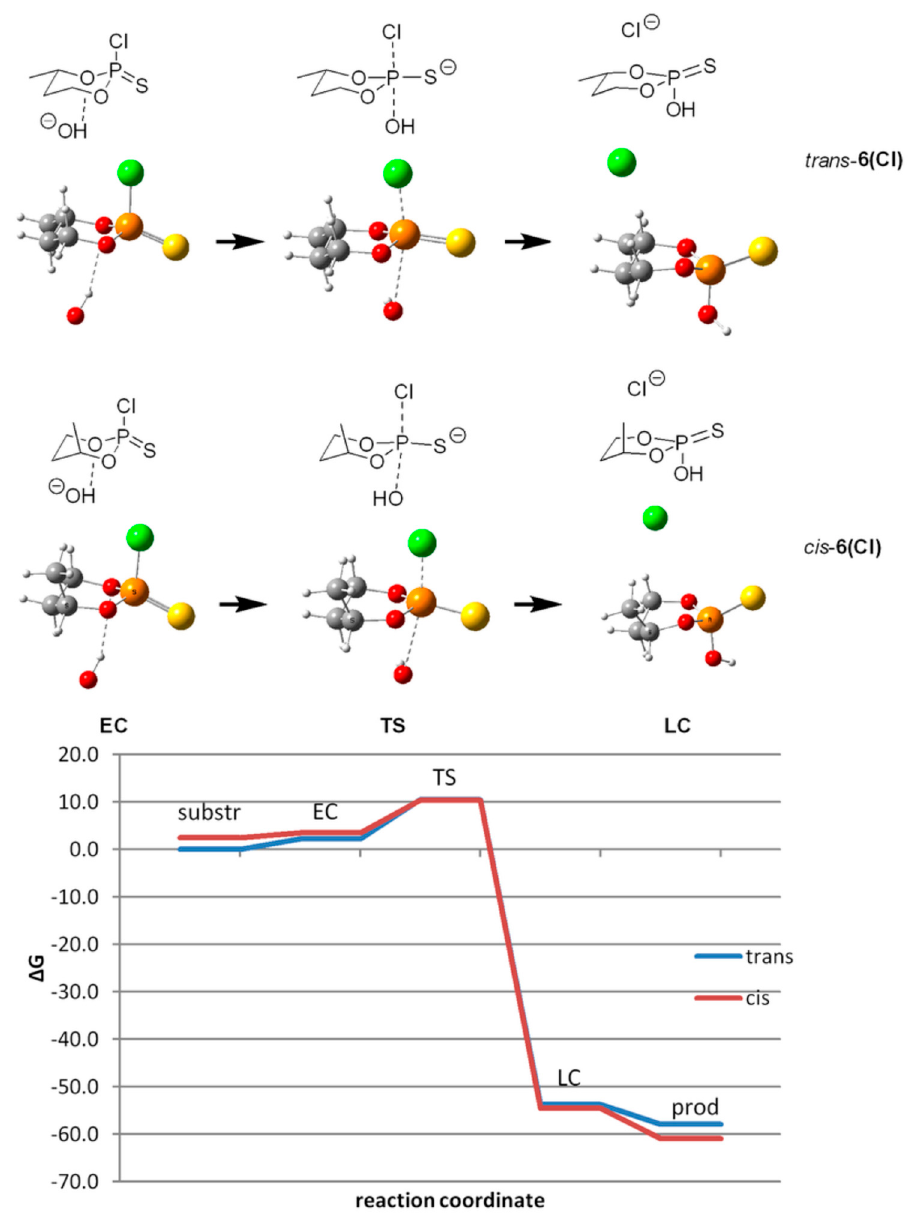
Figure 6. Relative free energy profile (kcal/mol) for the chloride–hydroxide exchange in trans- (blue line) and cis- (red line) 6(Cl) ; ( EC )-early complex (complex of substrates), ( TS )-transition state, ( LC )-late complex (complex of products).